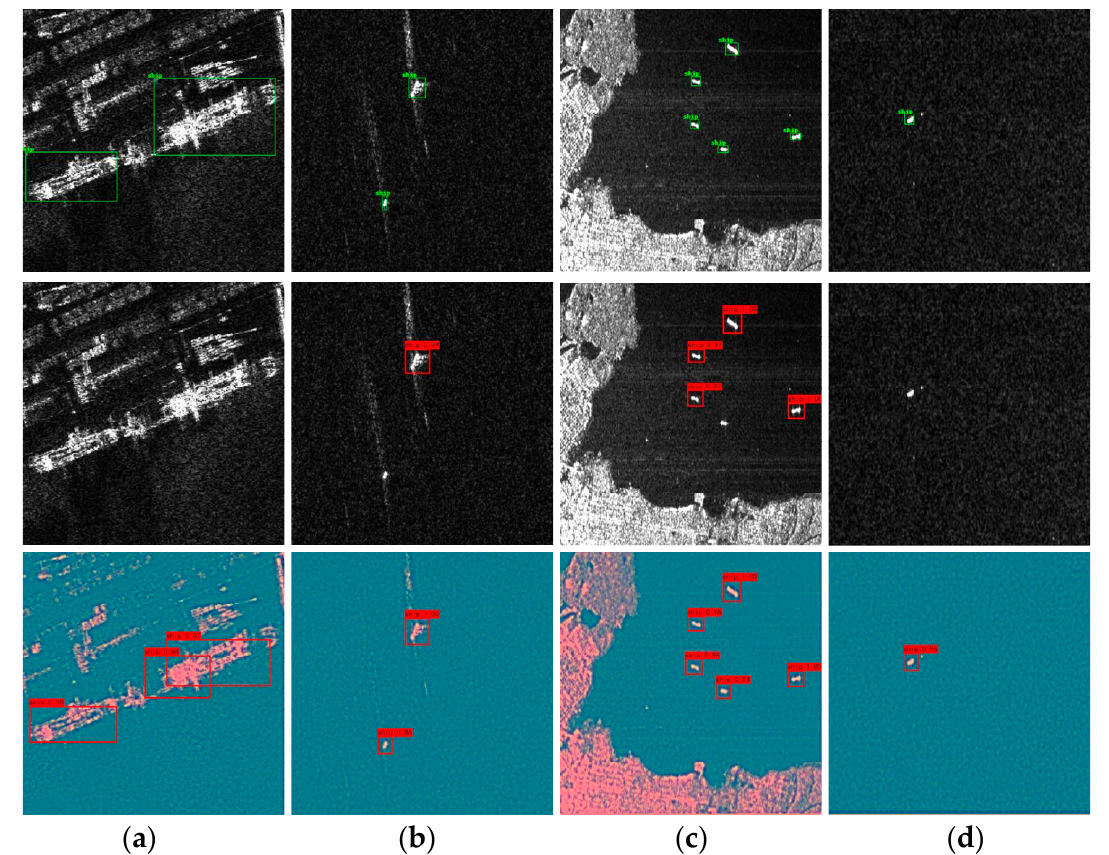
Figure 12. Ship detection ground truth and different recall result for YOLO-V4-tiny and YOLO-V4-light. ( a – d ) Comparison of the detection results of different algorithms in different scenarios.